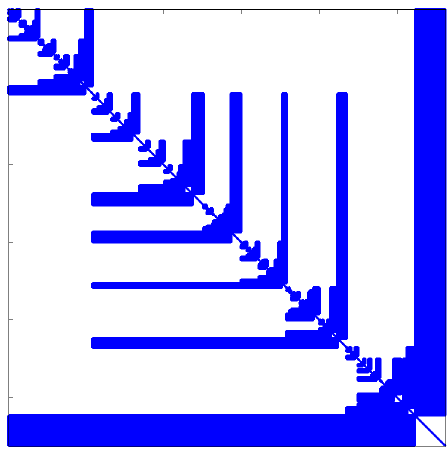
Figure 6. Arrowhead structure of the condensed mass matrix in automated multi-level sub-structuring